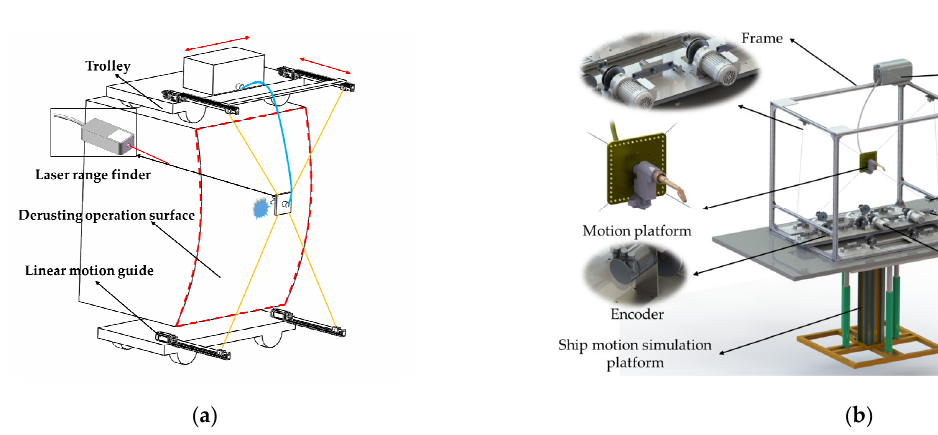
Figure 1. ( a ) Schematic diagram of working principle; ( b ) 3D model of the prototype.